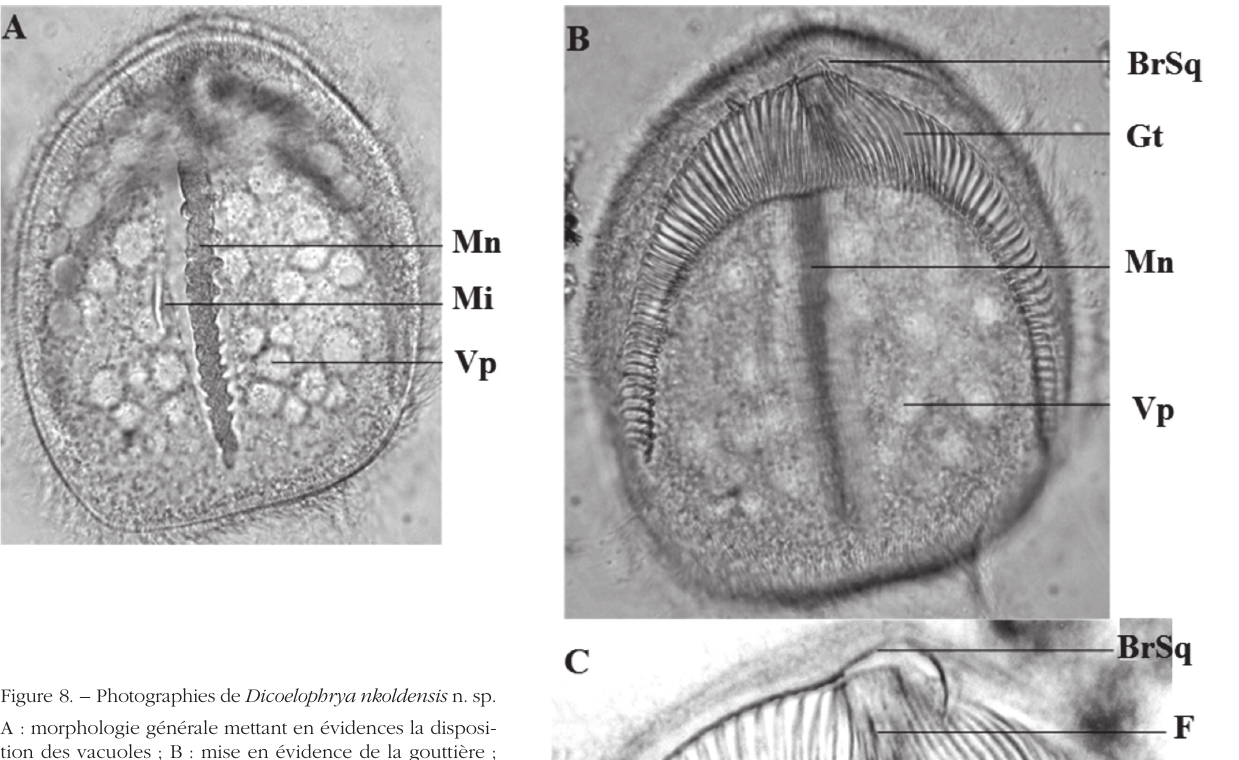
Figure 8. – Photographies de Dicoelophrya nkoldensis n.